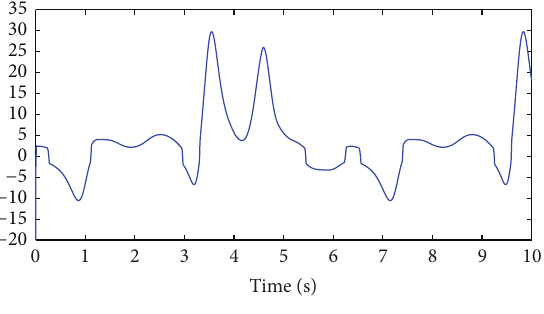
Figure 3: Control signal V 1 (𝑡)